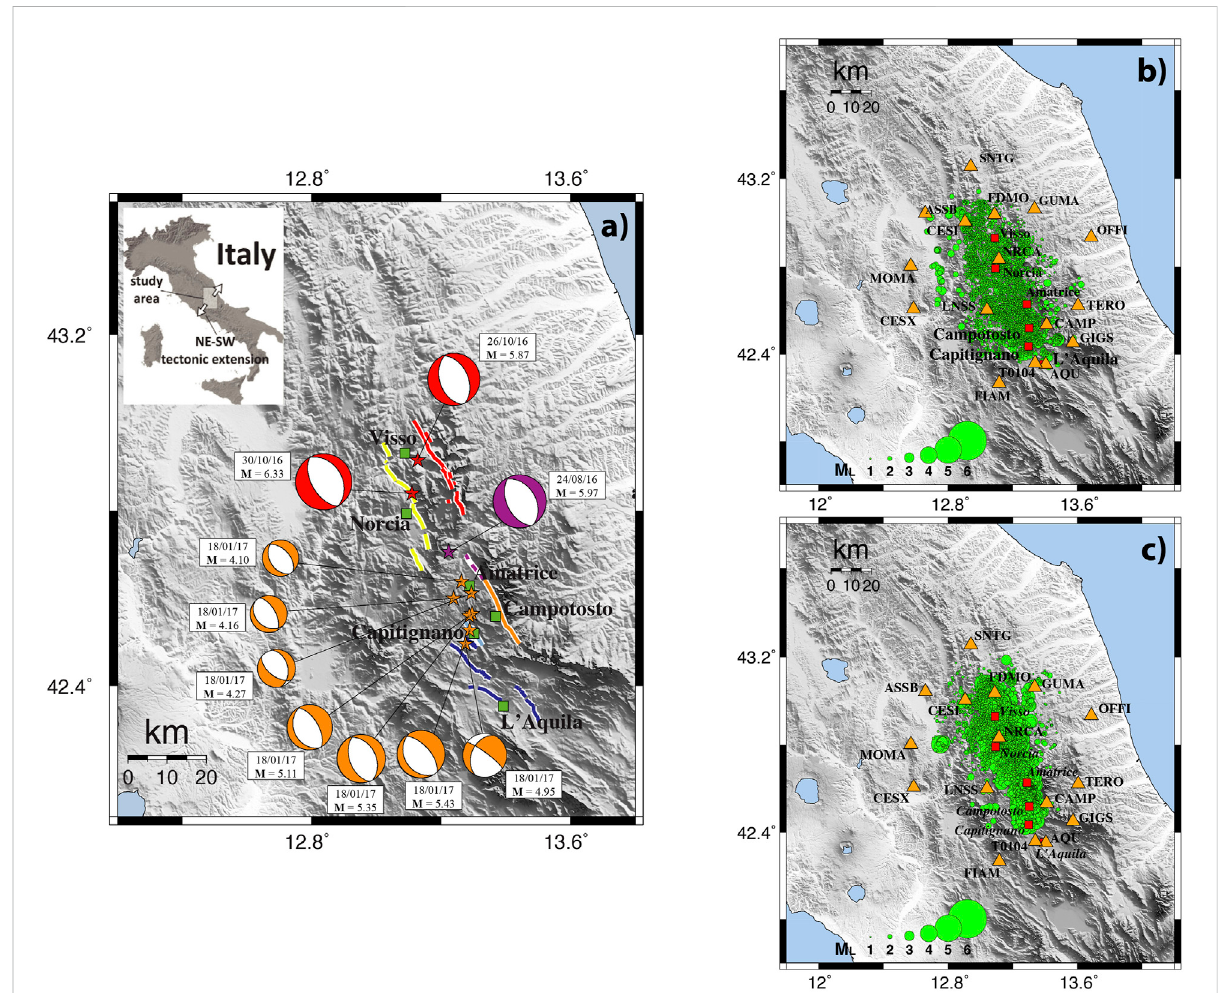
FIGURE 1 Representation of the data set. (A) : Mechanisms of selected earthquakes: the mainshocks of Amatrice, Visso and Norcia, and the seven largest events of Capitignano subsequence (from http://eqinfo.eas.slu.edu/eqc/eqc_mt/MECH.IT/). Fault traces are represented by colored lines (fault strands with thesame color pertain to thesame seismogenicfault system, from Gorietal., 2019). Faultsystems are matched with the corresponding focal solutions using the same color; stars correspond to the location of the mainshocks, and green squares represent the main cities of the area. (B) and (C) :Locations andmagnitudes ofthe13,980 earthquakesusedin thisstudy (1.1 < M < 6.0)occurredinthetime window between 01/01/ 2012 and 23/08/2016 (B) ) and between 24/08/2016 and 05/05/2022 (C) ); orange triangles in (B) and (C) indicate the positions of the 21 seismic stations listed in Table S1 of the Supplementary